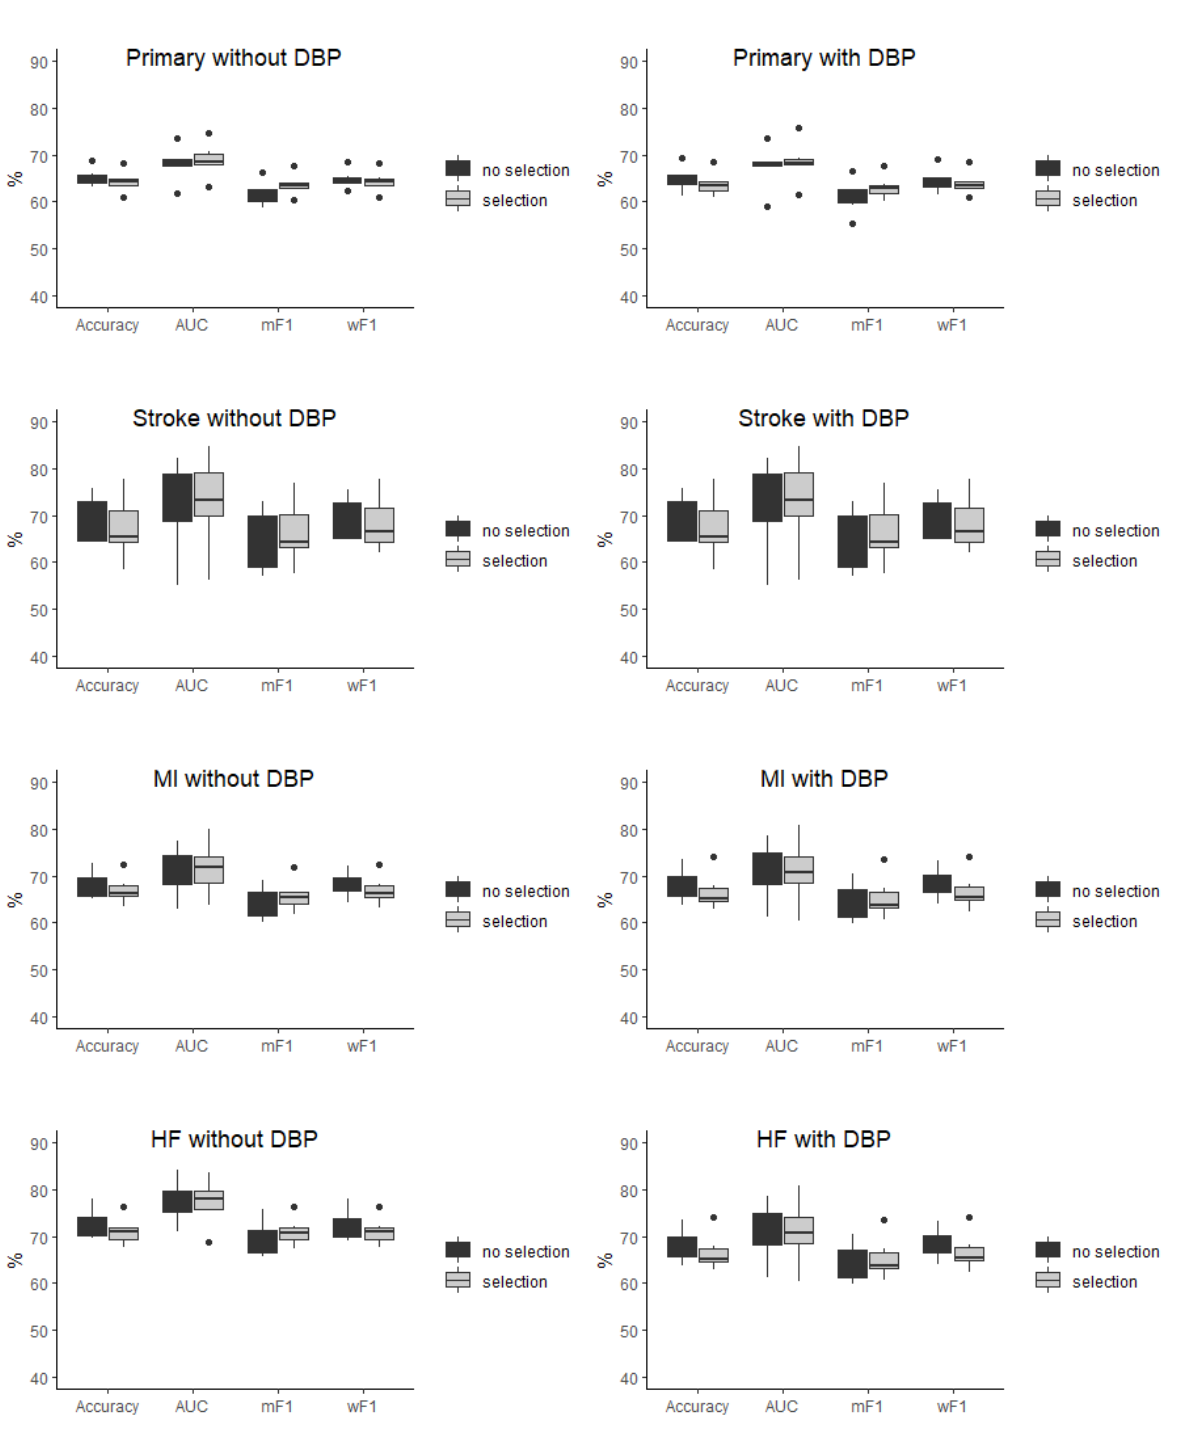
Figure 4. Comparison of the performance of the classifiers in the selected (selection) and unselected (no selection) population presented as boxplots for all of outcome variables when diastolic blood pressure was included and excluded as the predictor. AUC — area under curve, mF1 — mean F-measure, wF1 — mean weighted F-measure, no differences detected for all of the comparisons.